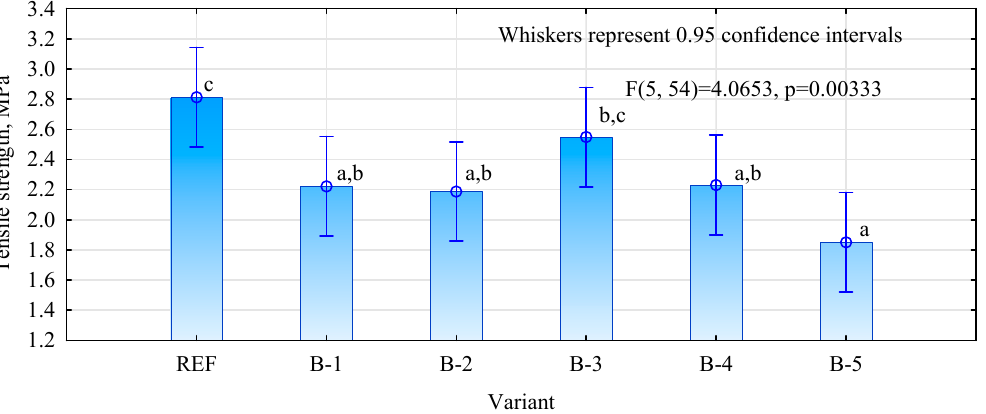
Figure 1. The changes in tensile strength of the produced plywood with bark: (B ‐ 1), beech (B ‐ 2), maple (B ‐ 3) and pine bark (B ‐ 4), spruce(B ‐ 5) and reference sample (REF). The lowercase letters means homogeneous